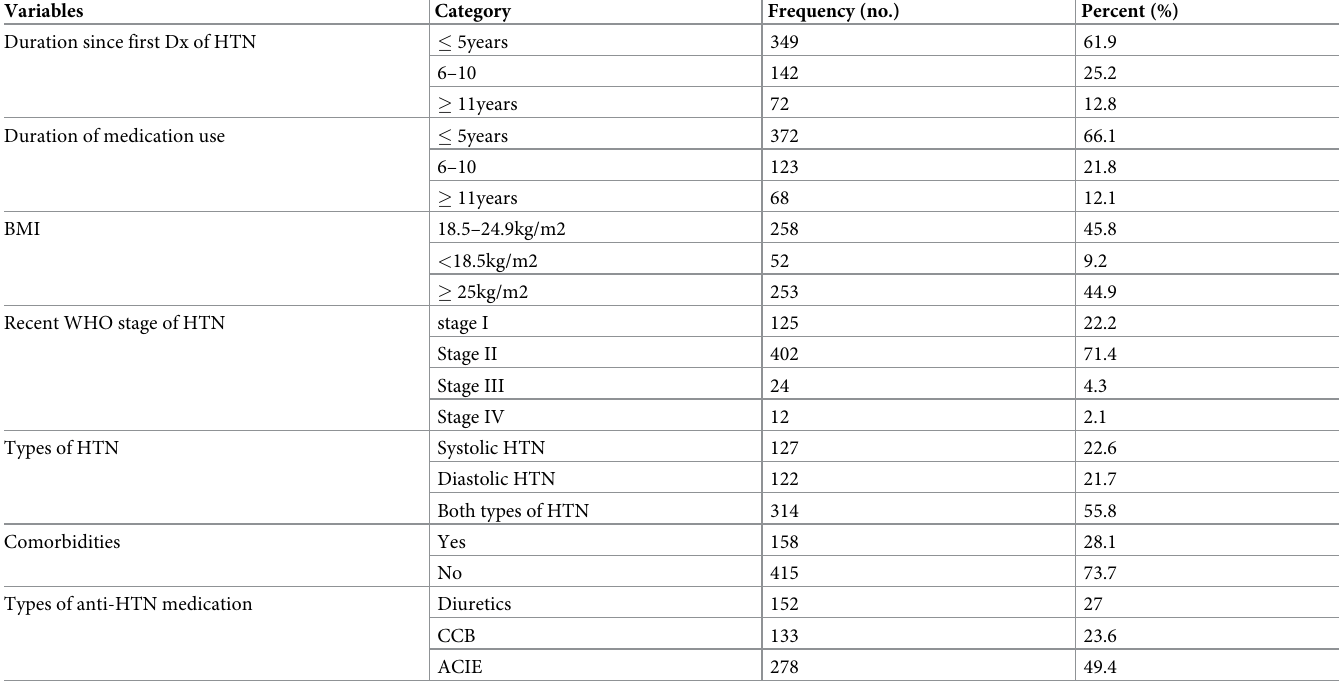
Table 2. Clinical characteristics of adult HTN patients at chronic follow-up care clinics in northwest Amhara regional state referral hospitals, Northwest Ethiopia, 2021 (n = 563). Variables